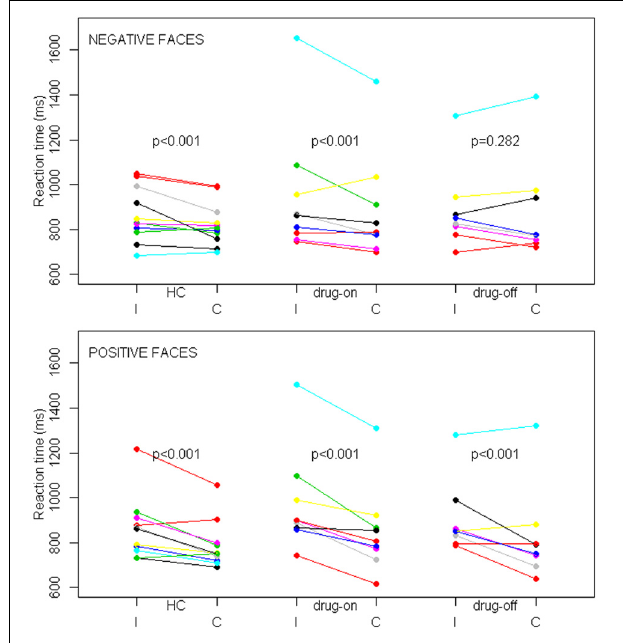
FIGURE 3 | SE task behavioral results in controls (HC), drug-off and drug-on parkinsonian patients. Data are patients’ mean reaction times expressed in milliseconds (ms) depending on the congruence (I, incongruent; C, congruent) and facial emotion conditions among the different groups. The top panel represents trials with negative faces and the bottom panel represents trials with positive faces. p represents the statistical significance of the reaction time difference between incongruent and congruent conditions. Differences were assessed with a linear mixed effects